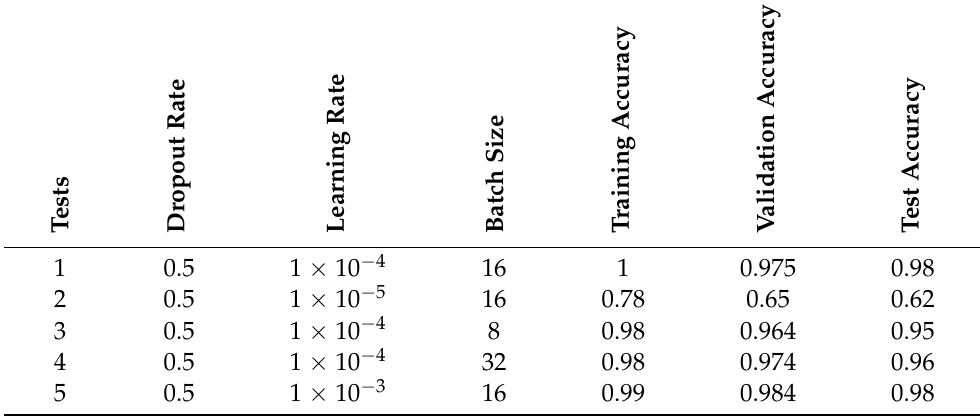
Table 8. Model performance on different combinations of hyper-parameters for Experiment 3.